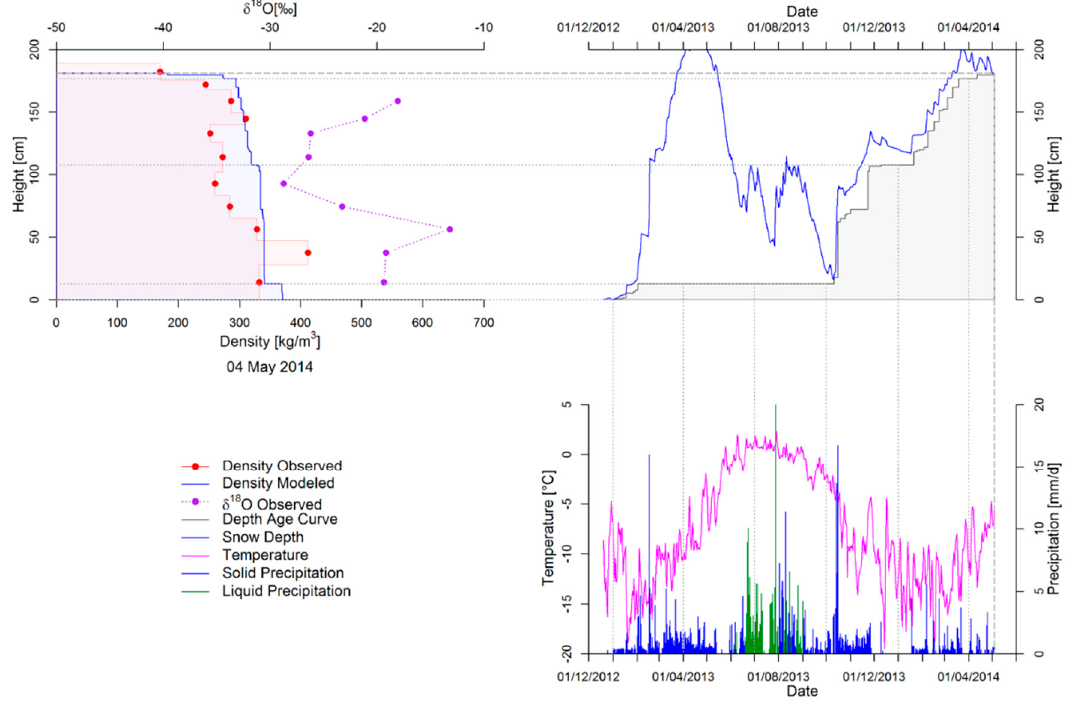
Figure 5. West Khangri Nup EV2CNR station (5601 m asl) snow pit on 4 May 2014. Top-left: Observed and Poli-Hydro simulated snow depth. Measured mass density and δ 18 O profile. Top-right: Poli-Hydro simulated snow depth and observed snow layers in the snow pit. Bottom-right: Precipitation partitioning and temperature during the 4 May 2014 snow pack accumulation period (explained in Section 5.3).